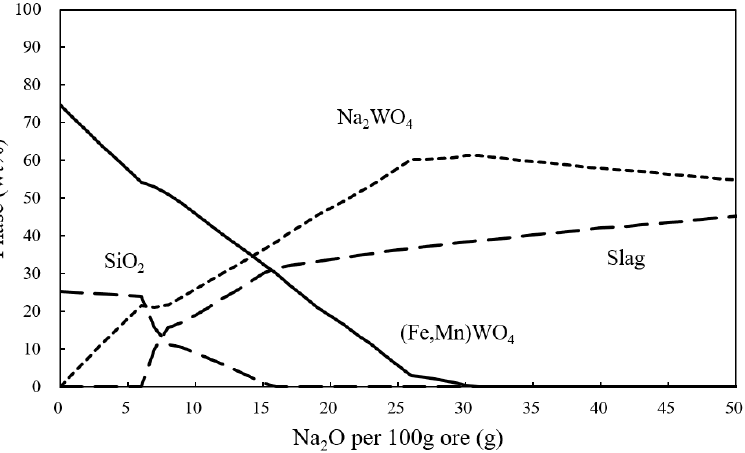
Figure 7. Changes of phases with the increase in Na 2 O addition in argon at 1200 °C, calculated by FactSage 8.2.